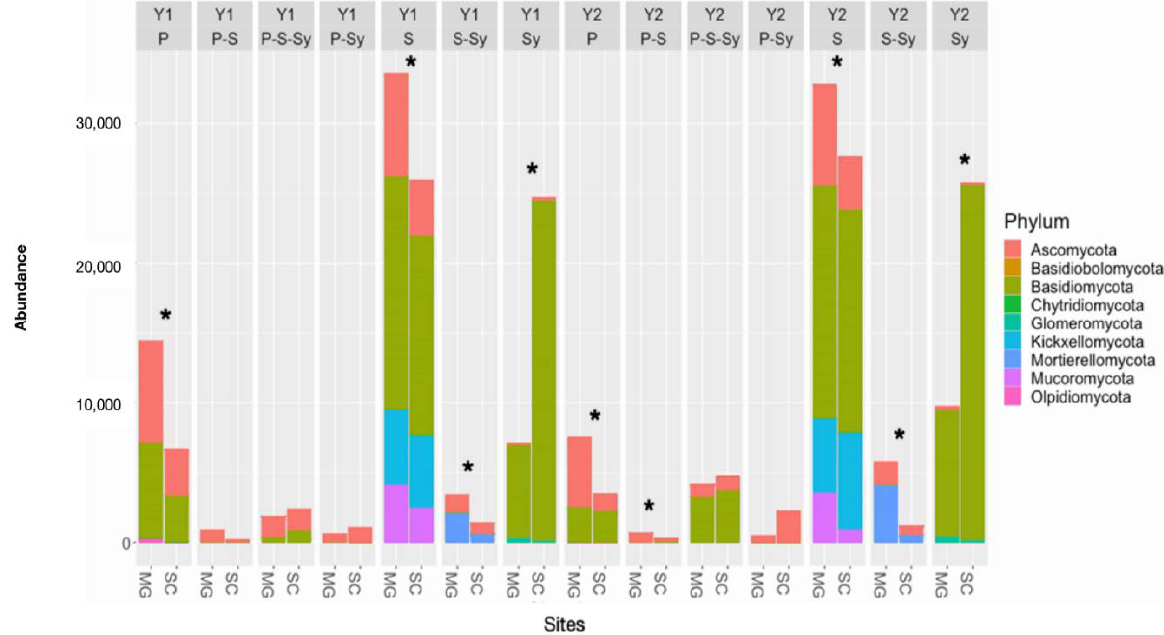
Figure 3. Trophic distribution and phylum composition of OTUs retrieved from Morgex (MG) and Saint Christophe (SC) at sampling time Y1 (first year) and Y2 (second year). S, saprotrophs; Sy symbiotrophs; P, pathotrophs (fungi showing different trophic behaviors are separately annotated). Data are expressed as percentage (mean ± standard deviation). *: indicate significant differences (Anova; Mann-Whitney pairwise comparison; Bonferroni corrected p values; p < 0.05).